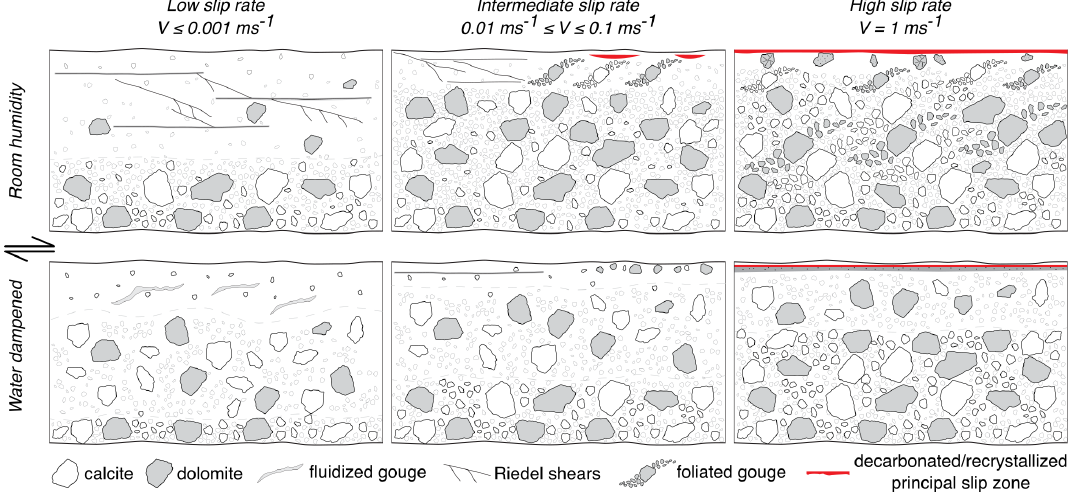
Figure 11. Summary of microstructural evolution at different slip rates and deformation